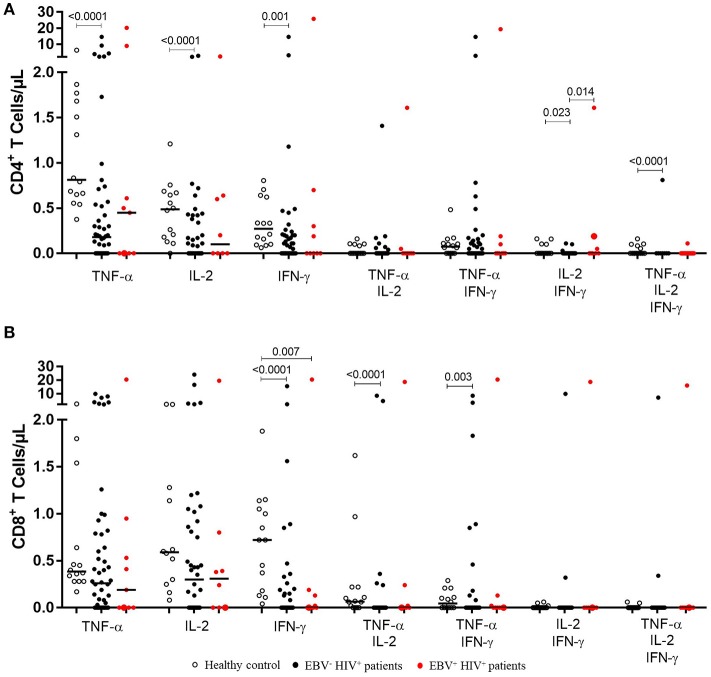
Functional EBV-specific T cell response in EBV−HIV+ vs. EBV+HIV+ patients. Peripheral blood samples of HIV+ patients and healthy controls were cultured in vitro with EBV lysate. Counts of mono- and multifunctional (TNF-α+, IFN-γ and/or IL-2) CD4+ (A) and CD8+ (B) T cells were analyzed by flow cytometry. Net (EBV minus basal) counts are shown. Bold lines represent median values. Mann-Whitney U-test was used for comparisons between groups.